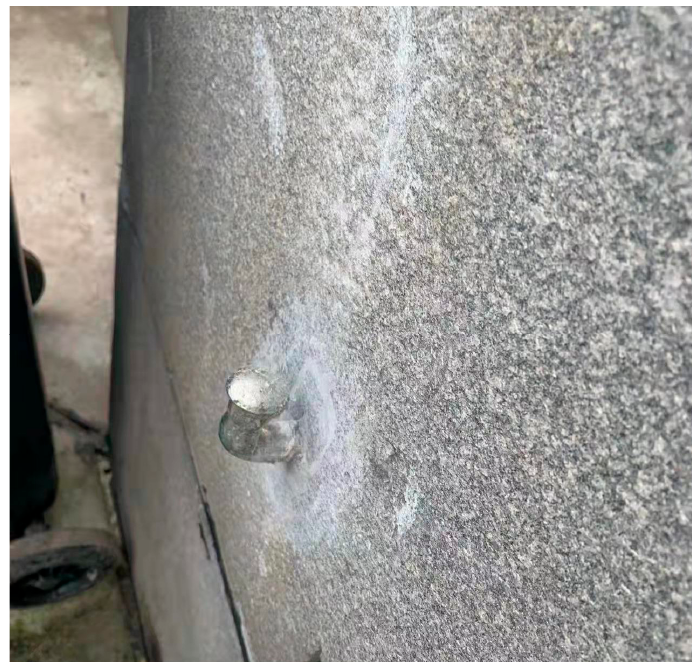
Figure 6. Monitoring point on the adjacent